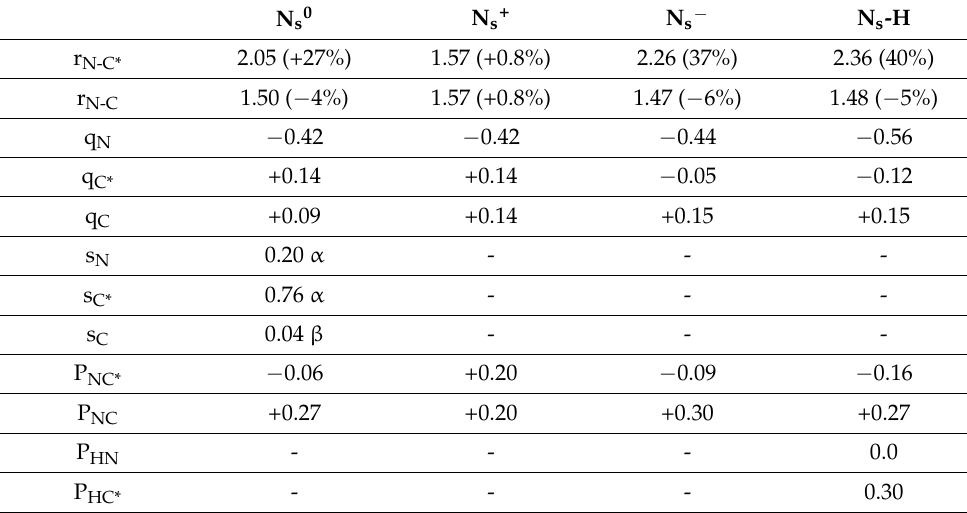
Table 1. Optimised (nn) N-C distances (Å), r N-C* , r N-C and B3LYP atomic charges ( | e | ), q N , q C* , q C , atomic spins ( | e | ), s N , s C* , s C , and overlap charges ( | e | ), P NC* , P NC , P HN , P HC* in N s0 , N s+ , N s − and N s -H. Numbers in brackets are the % difference from the diamond C-C